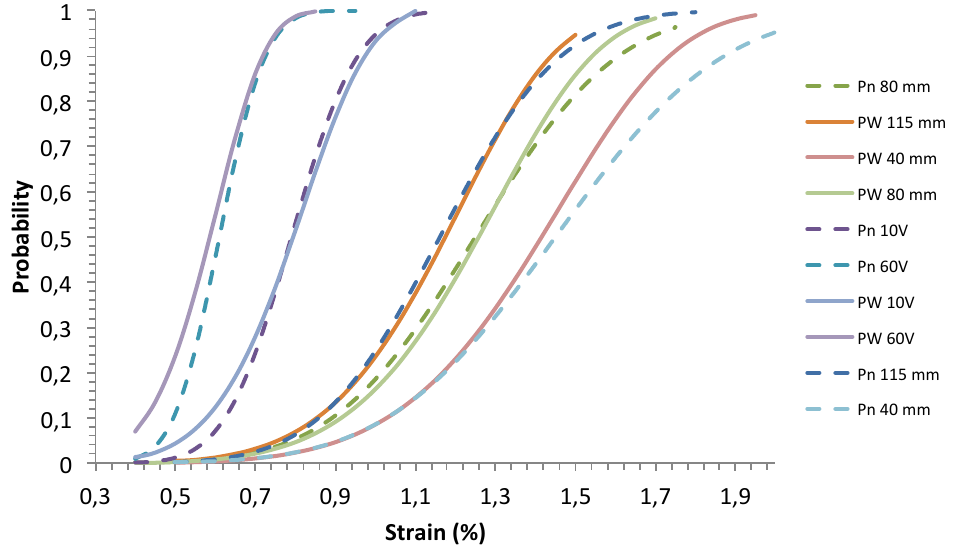
Figure 10. Comparison of predicted cumulative normal (Pn) and Weibull (PW) distribution functions for various gauge lengths: 115 mm (basis), 40 mm, 80 mm, 1150 mm (10 V) and 6900 mm (60 V).